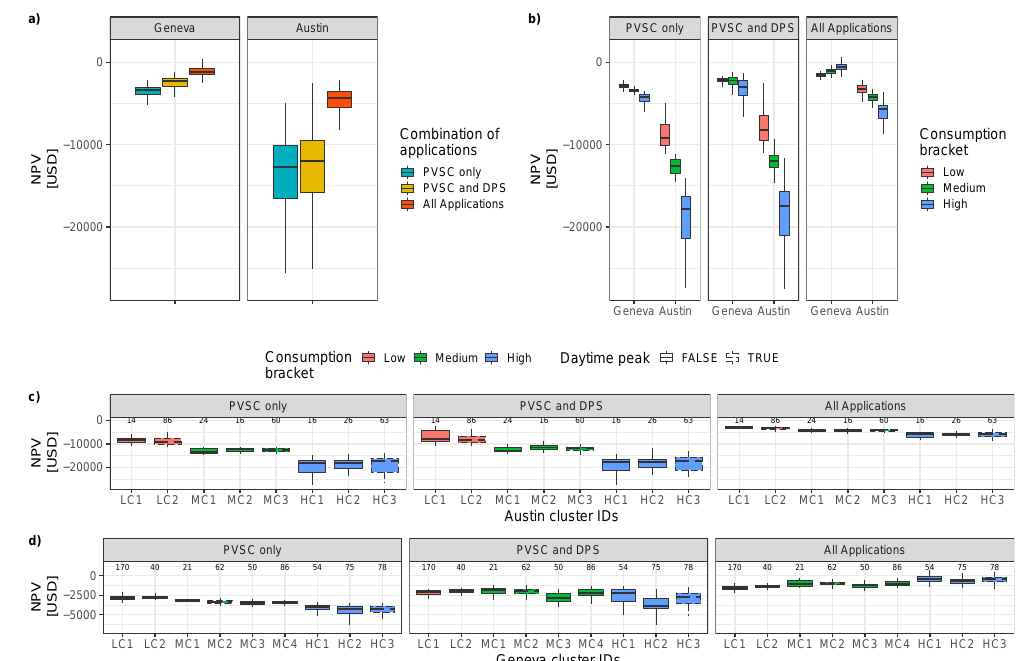
Figure 8. NPV achieved by PV-coupled batteries. ( a ) Comparing the impact of the combination of applications per country; ( b ) Comparing the consumption bracket impact per country and per combination of applications; ( c ) Comparing the impact of the load profile (cluster) per consumption bracket and per combination of applications for Austin and; ( d ) Comparing the impact of the load profile (cluster) per consumption bracket and per combination of applications for Geneva. All values presented in this graph refer only to the investment in the battery, i.e., the cost of the PV panel is excluded. Dashed boxplots represent households with peaks during daytime (i.e., from 10 a.m. to 6 p.m.). The number of observation per cluster is indicated on top of the boxplots. PVSC stands for PV self-consumption and DPS for demand peak